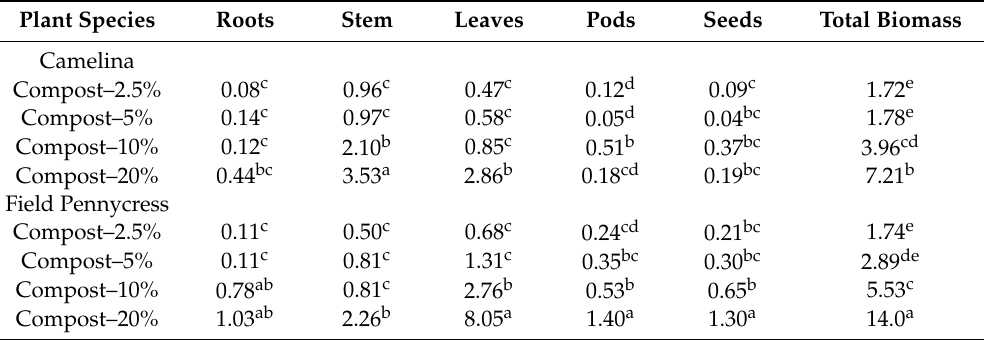
Table 2. Plant yield (oven dried; g) of camelina and field pennycress in the column study. Plant Species